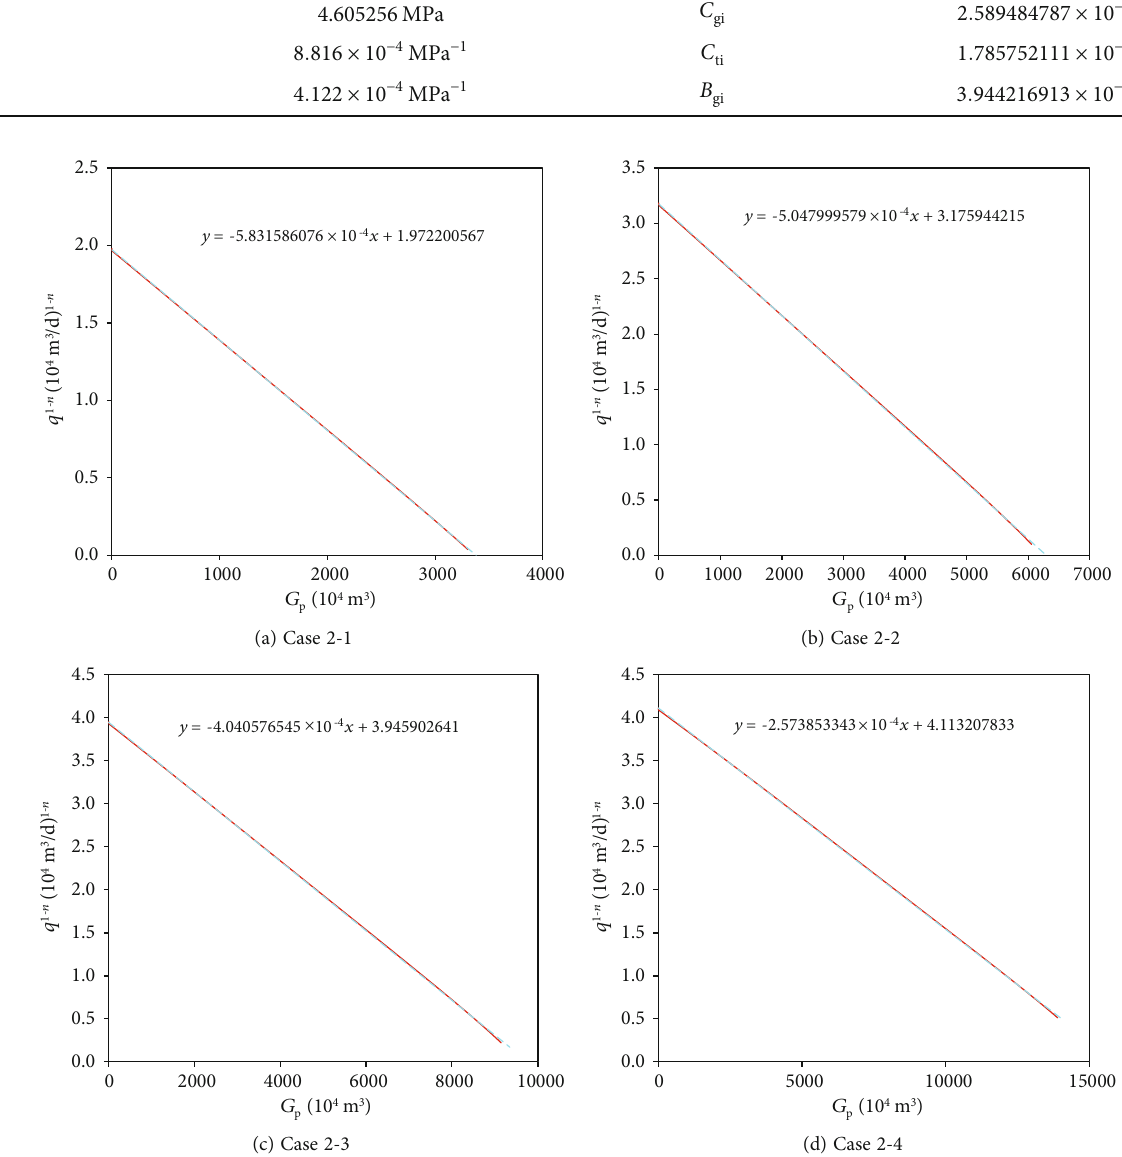
Figure 36: q 1 − n vs. G for the simulated gas reservoir with high p